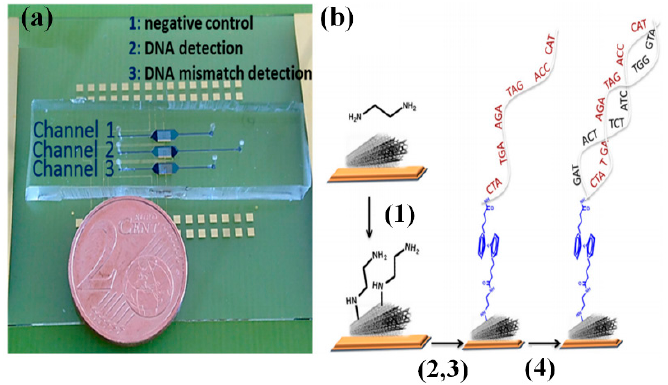
Figure 15. A scheme showing on-chip specific detection of HCV and Mycobacterium tuberculosis (Reproduced from [103]).